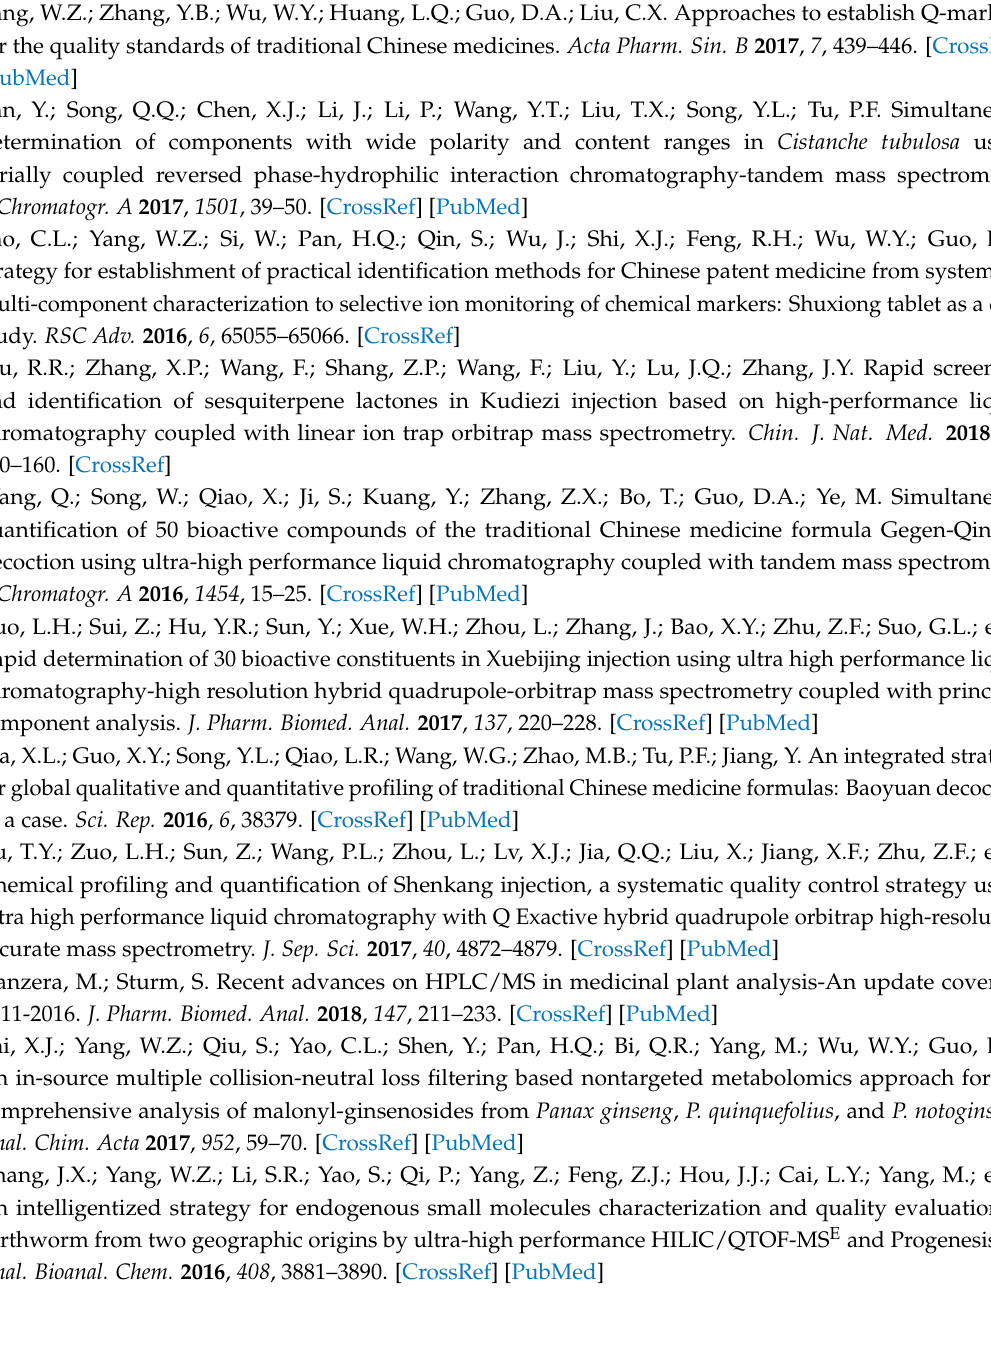
Supplementary Materials: The following are available online: Table S1: Detailed information of 30 reference compounds and their MS data acquired from the EZP sample by UHPLC/Q-Orbitrap-MS; Table S2: Detailed information of the 96 components characterized from EZP; Table S3: Information of the 270 components failing to be characterized from EZP; Table S4: Information of the LLF, EH, and EZP samples analyzed in this